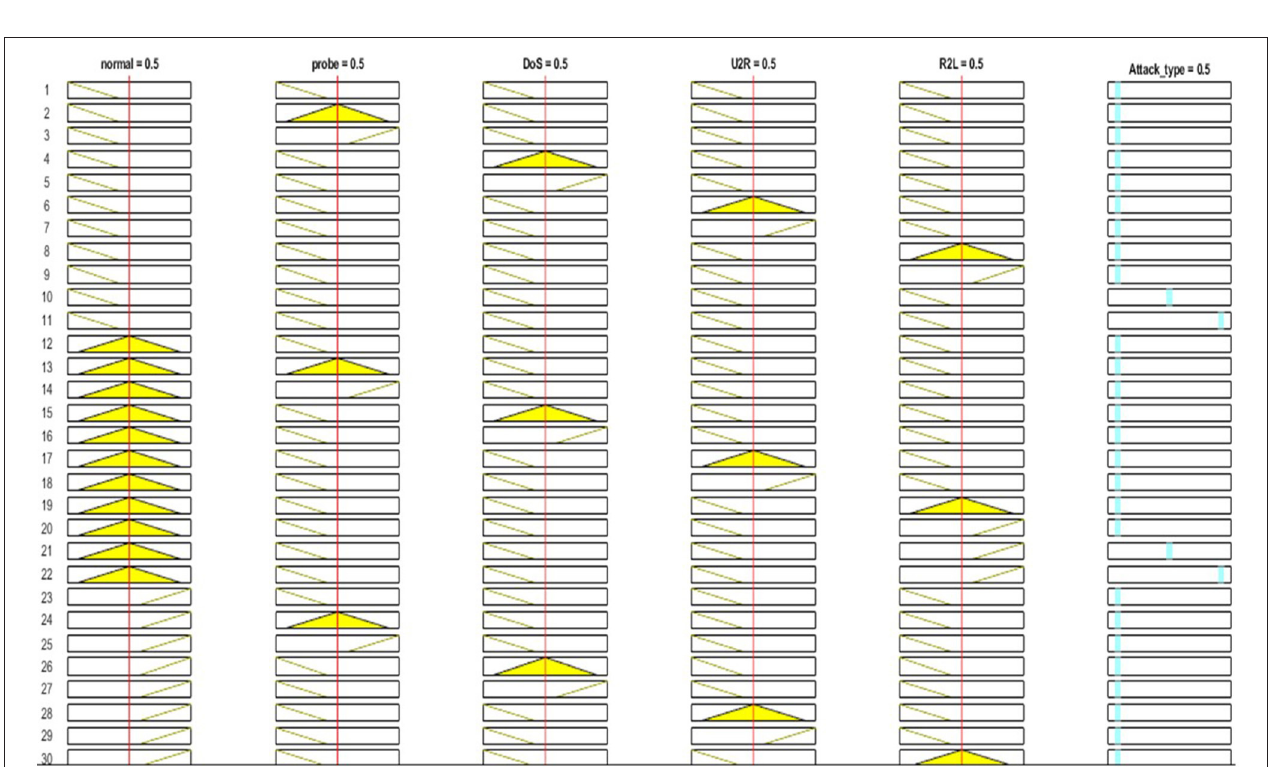
FIGURE 5 | Set of rules based on membership